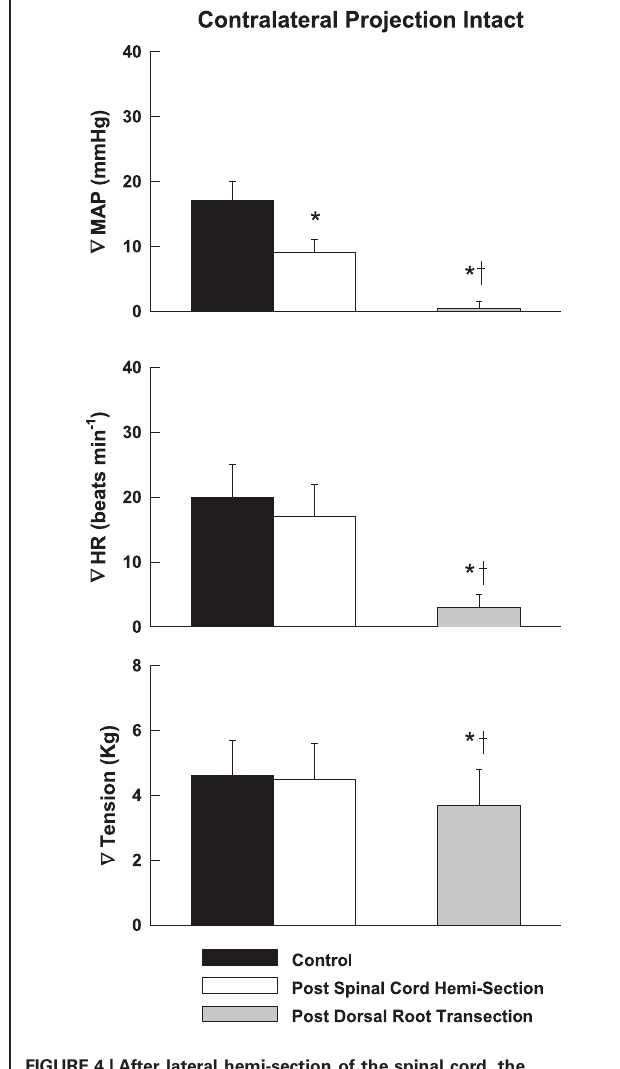
FIGURE 3 | After lateral hemi-section of the spinal cord, the exercise-induced increases in MAP were attenuated compared to control when contracting the leg contralateral to the lesion (ipsilateral sensory projection intact). HR responses were largely unaffected. Sectioning the dorsal roots innervating the activated hindlimb skeletal muscle almost completely abolished the cardiovascular response to exercise. Asterisk indicates significantly different from control condition. Cross indicates significantly different from spinal cord hemi-section condition ( P < 0 . 05).